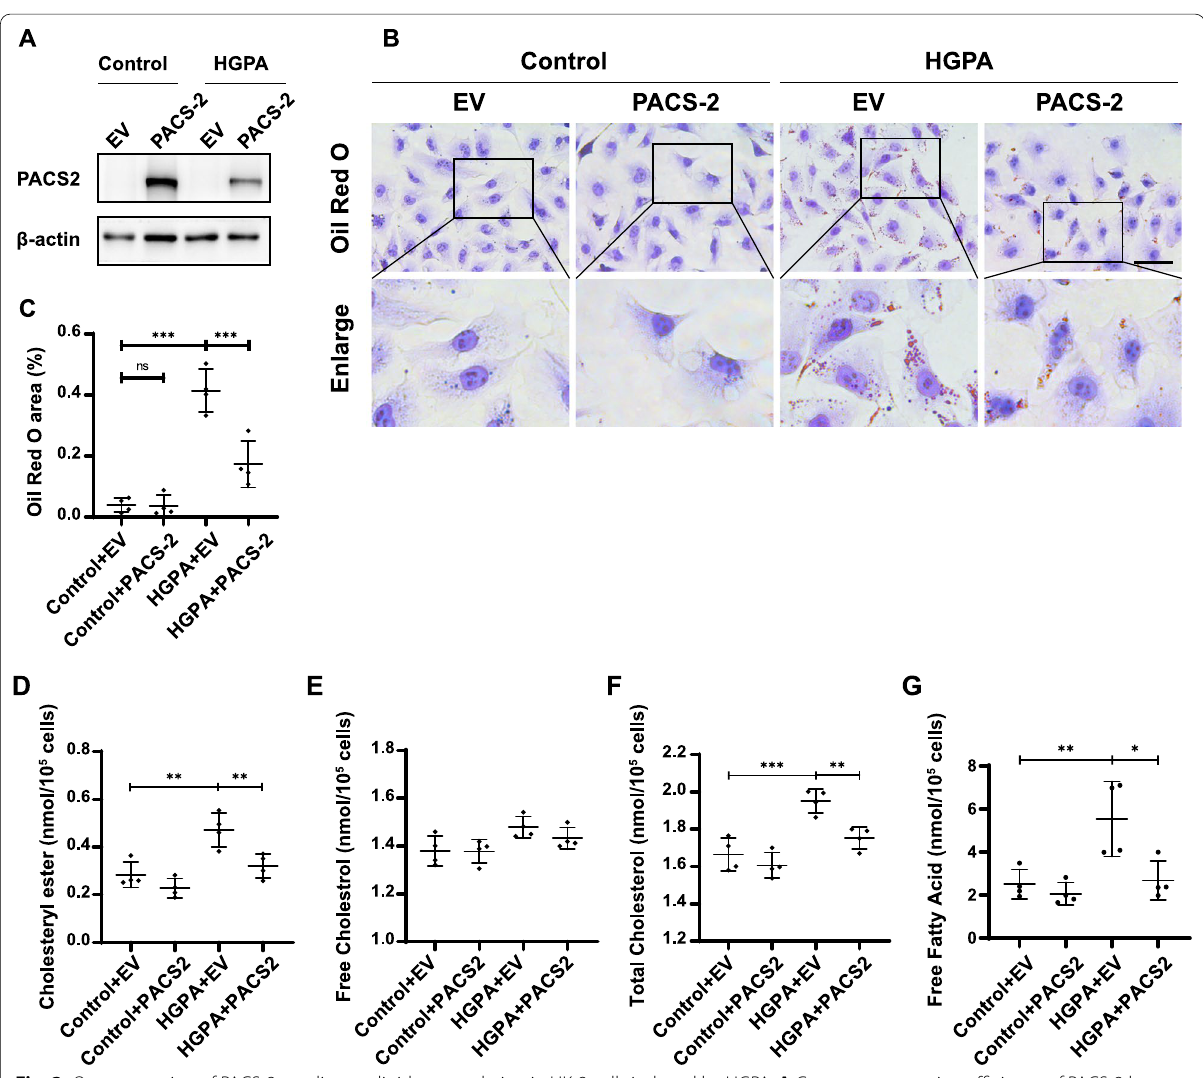
Fig. 3 Overexpression of PACS-2 ameliorates lipid accumulation in HK-2 cells induced by HGPA. A Gene overexpression efficiency of PACS-2 by western blot analysis in PACS-2 plasmid transfected HK-2 cells. B Representative Oil Red O staining images of HK-2 cells in different groups. Scale bar: 20 μm. C Oil Red O staining area. D Cholesteryl ester content. E Free cholesterol content. F Total cholesterol content. G Free fatty acid content. All data are presented as means SD; *p < 0.05, **p < 0.01, ***p < 0.001. n 4 ± =